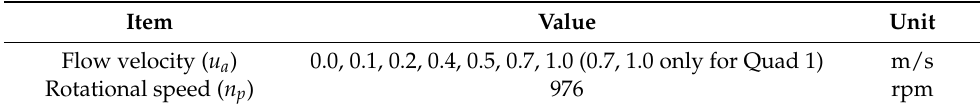
Table 4. Propeller Open Test